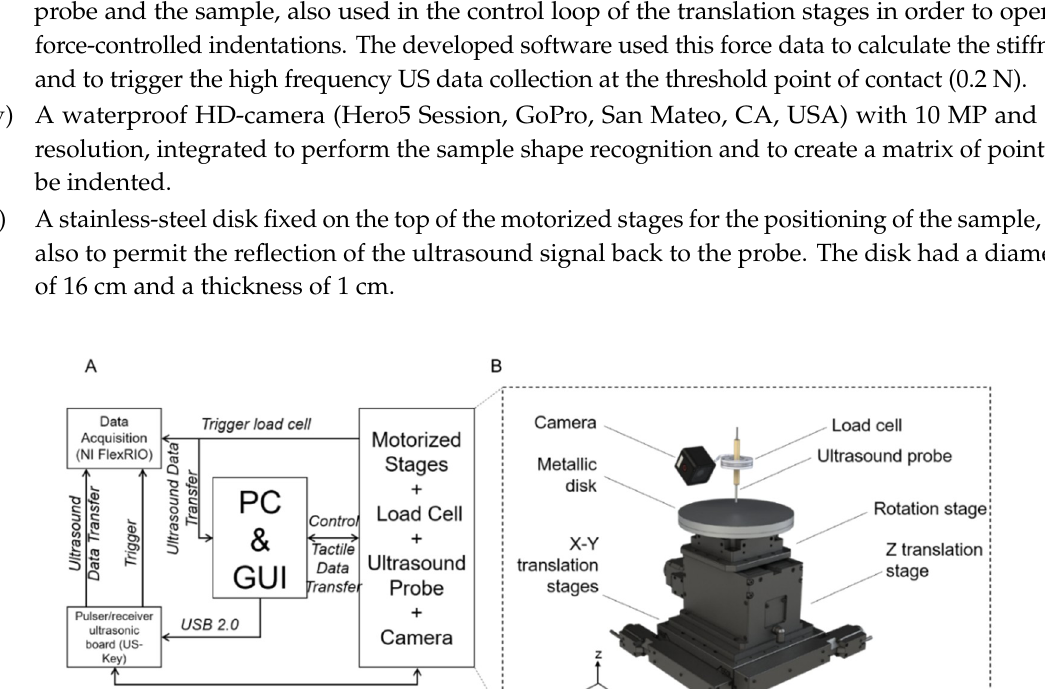
Figure 3. Rendering of the Agar phantom used during the experimental acquisition. The spherical inclusions are marked in yellow ( ∅ 12–9–6–3 mm). The volume of the phantom is 100 × 60 × 15 mm 3 .